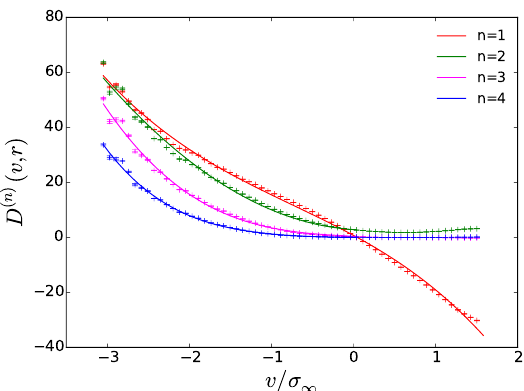
Figure 11. Estimation of the Kramers–Moyal coefficients from DNS of Burgers turbulence for r = L /2. The fits correspond to polynomials of the order n of the coefficient except for n = 1 where a polynomial of order three has been used. The reduced Kramers–Moyal coefficients have been determined according to K 1 = 1.1689 ± 0.08, K 2 = 0.7880 ± 0.14, K 3 = 0.6956 ± 0.17 and K 4 = 0.7137 ± 0.12